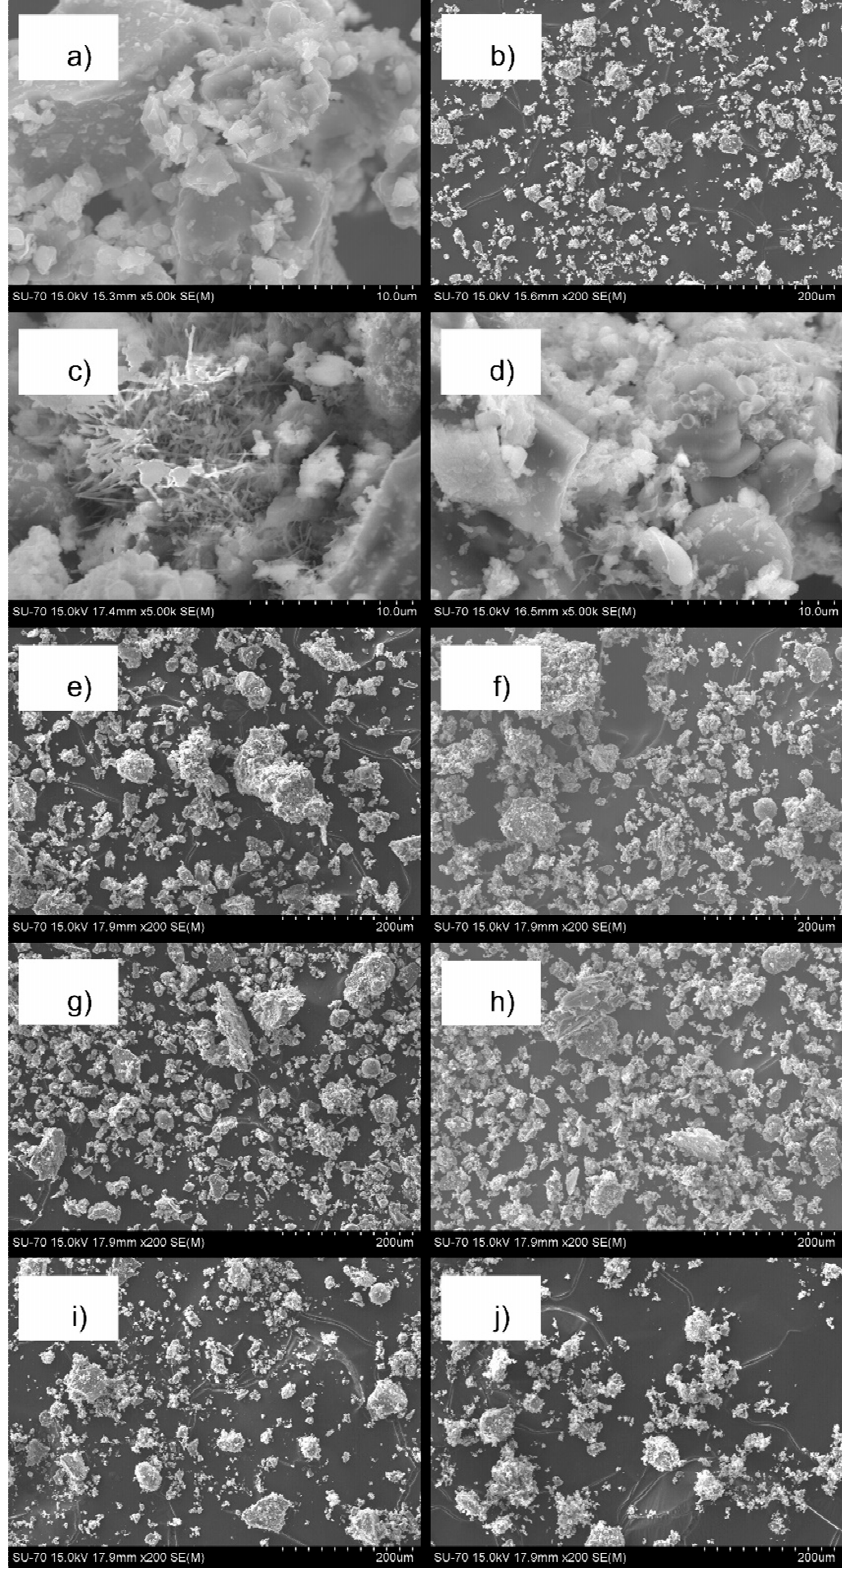
Figure 2. SEM micrographs of the materials under study: ( a ) OPC, ( b ) OPC, ( c ) BFA1, ( d ) BFA2, ( e ) BFA1, ( f ) BFA2, ( g ) BFA1_S, ( h ) BFA2_S, ( i ) BFA1_GS and ( j ) BFA2_GS.